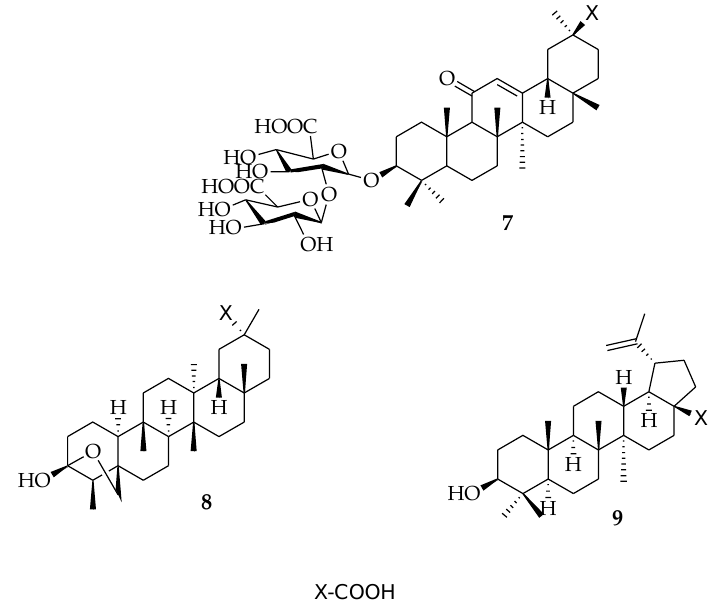
Figure 2. Isolated antiviral compounds from plants.